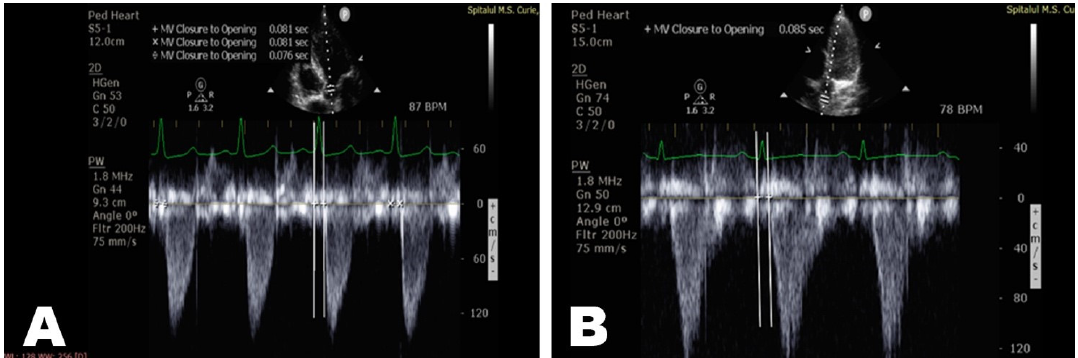
Figure 2. Measurement of ∆ T1 (T1-T0 = 85 − 81 = 4 msec) in the ascending aorta (echocardiography— apical window 5C) ( A , B